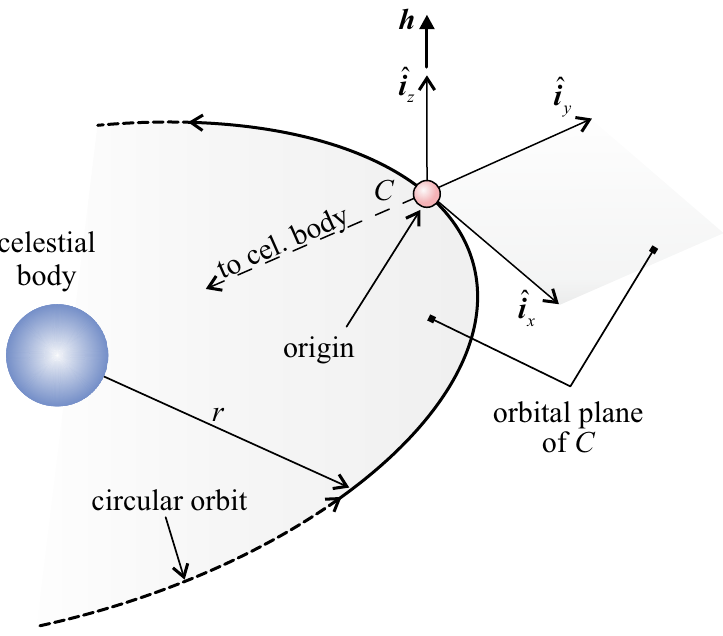
Figure 3. Local–vertical–local–horizontal (or Hill’s) reference frame T H ( C ; ˆ i x , ˆ i y , ˆ i z )